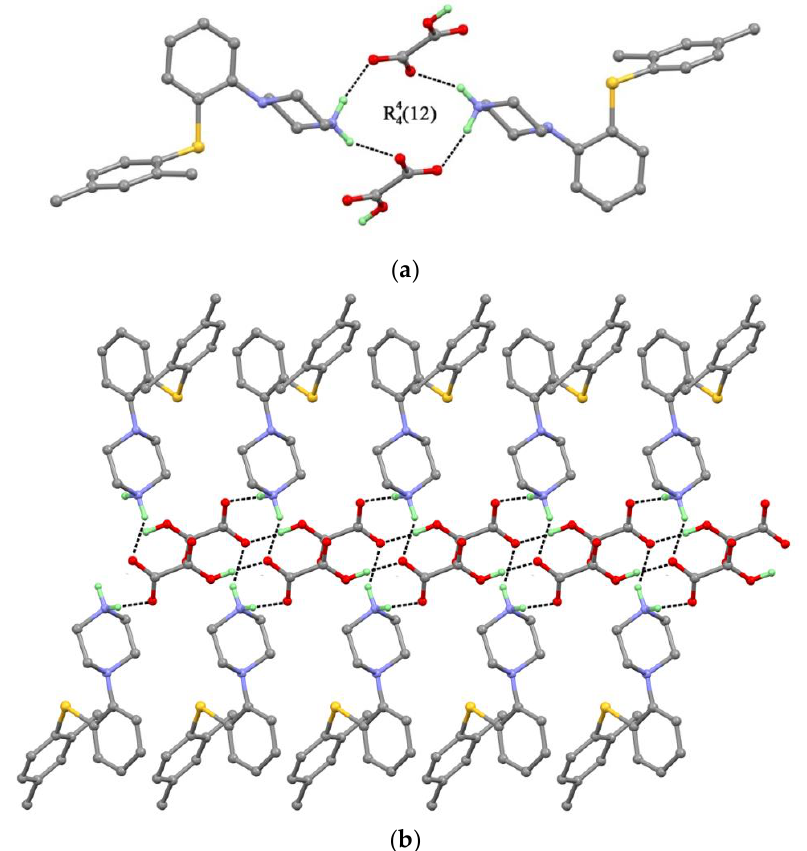
Figure 2. ( a ) Inversion related VOT-OA salt molecules connected by N + -H···O hydrogen bonds in